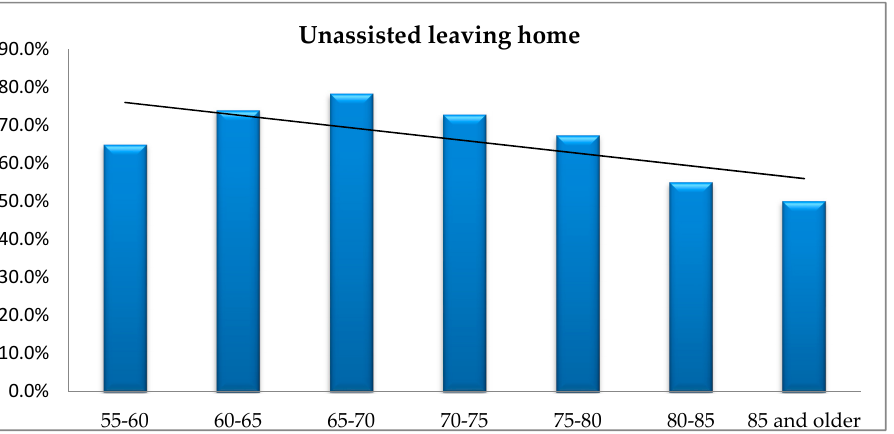
Figure 8. The respondents’ age vs. unassisted leaving home.